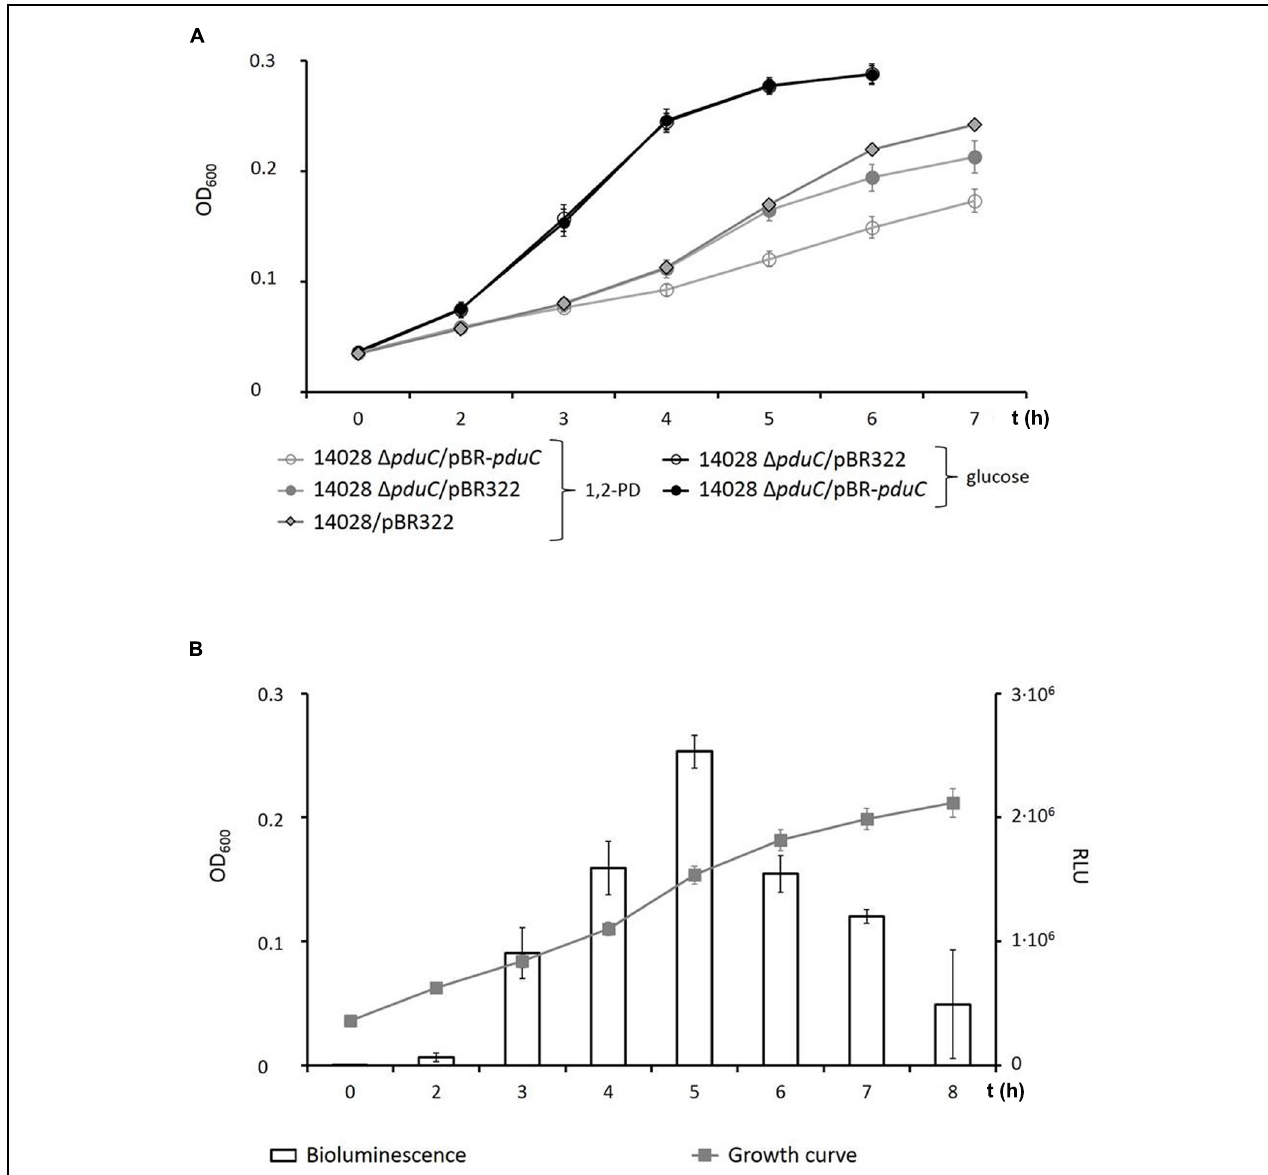
FIGURE 2 | Growth assays of strain 14028 with 1,2-PD. (A) Strains 14028/pBR322, 14028 (cid:2) pduC /pBR322, and 14028 (cid:2) pduC /pBR- pduC were cultivated in 50-ml cultures of VB-NCE-YE medium supplemented with trace elements, 40 mM tetrathionate and 25 mM 1,2-PD (gray traces), or 27.8 mM glucose as control (black traces) in an oxygen-free environment. Samples were taken at the indicated time points and transferred to microtiter plates to monitor the OD 600 . (B) The transcriptional activity of pduA was determined using reporter strain 14028 P pduA :: lux . OD 600 and RLU 490 were measured in parallel. Standard deviations of three independent experiments are